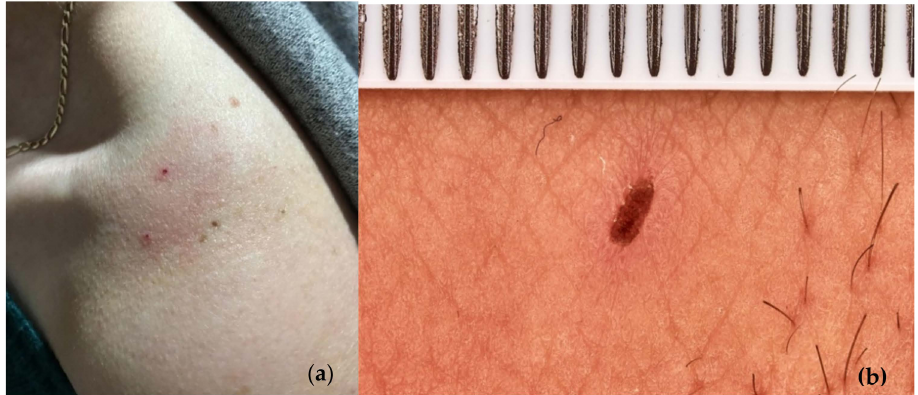
Figure 21. ( a ) Skin rashes on woman clavicle originated by overstressed LAB bite; ( b ) detail of skin-rush provoked by LAB biting on individual’s